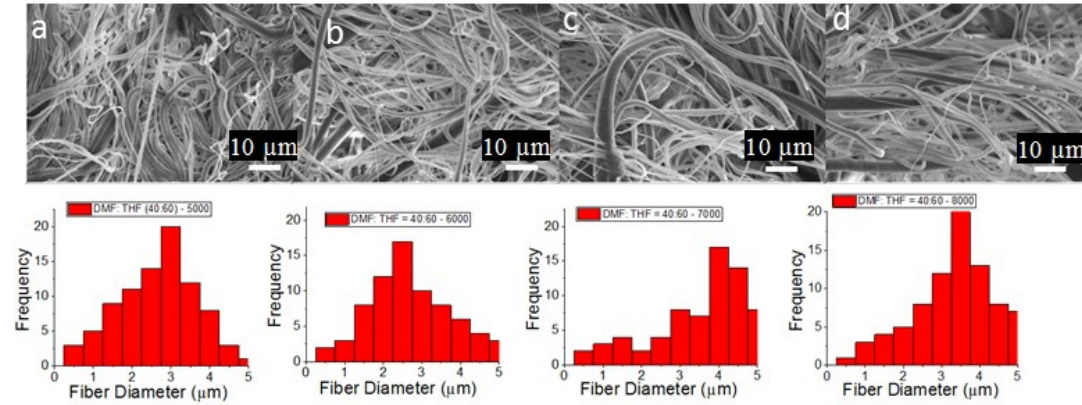
Figure 8. SEM images of the PCL fibers from solvent ratio 30:70 of DMF:THF mixture at different rotational speeds used, ( a ) 5000 rpm; ( b ) 6000 rpm; ( c ) 7000 rpm; ( d ) 8000 rpm and corresponding histogram of the fiber diameters.